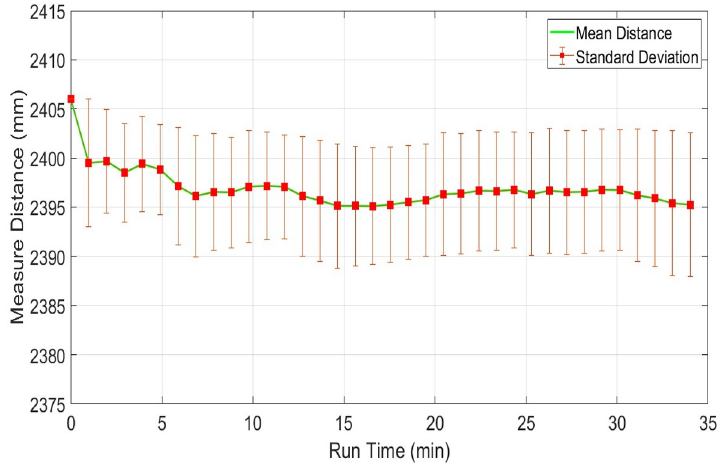
Fig 13. Range plot of RPLidar for measuring stability test for object present at 2.4m